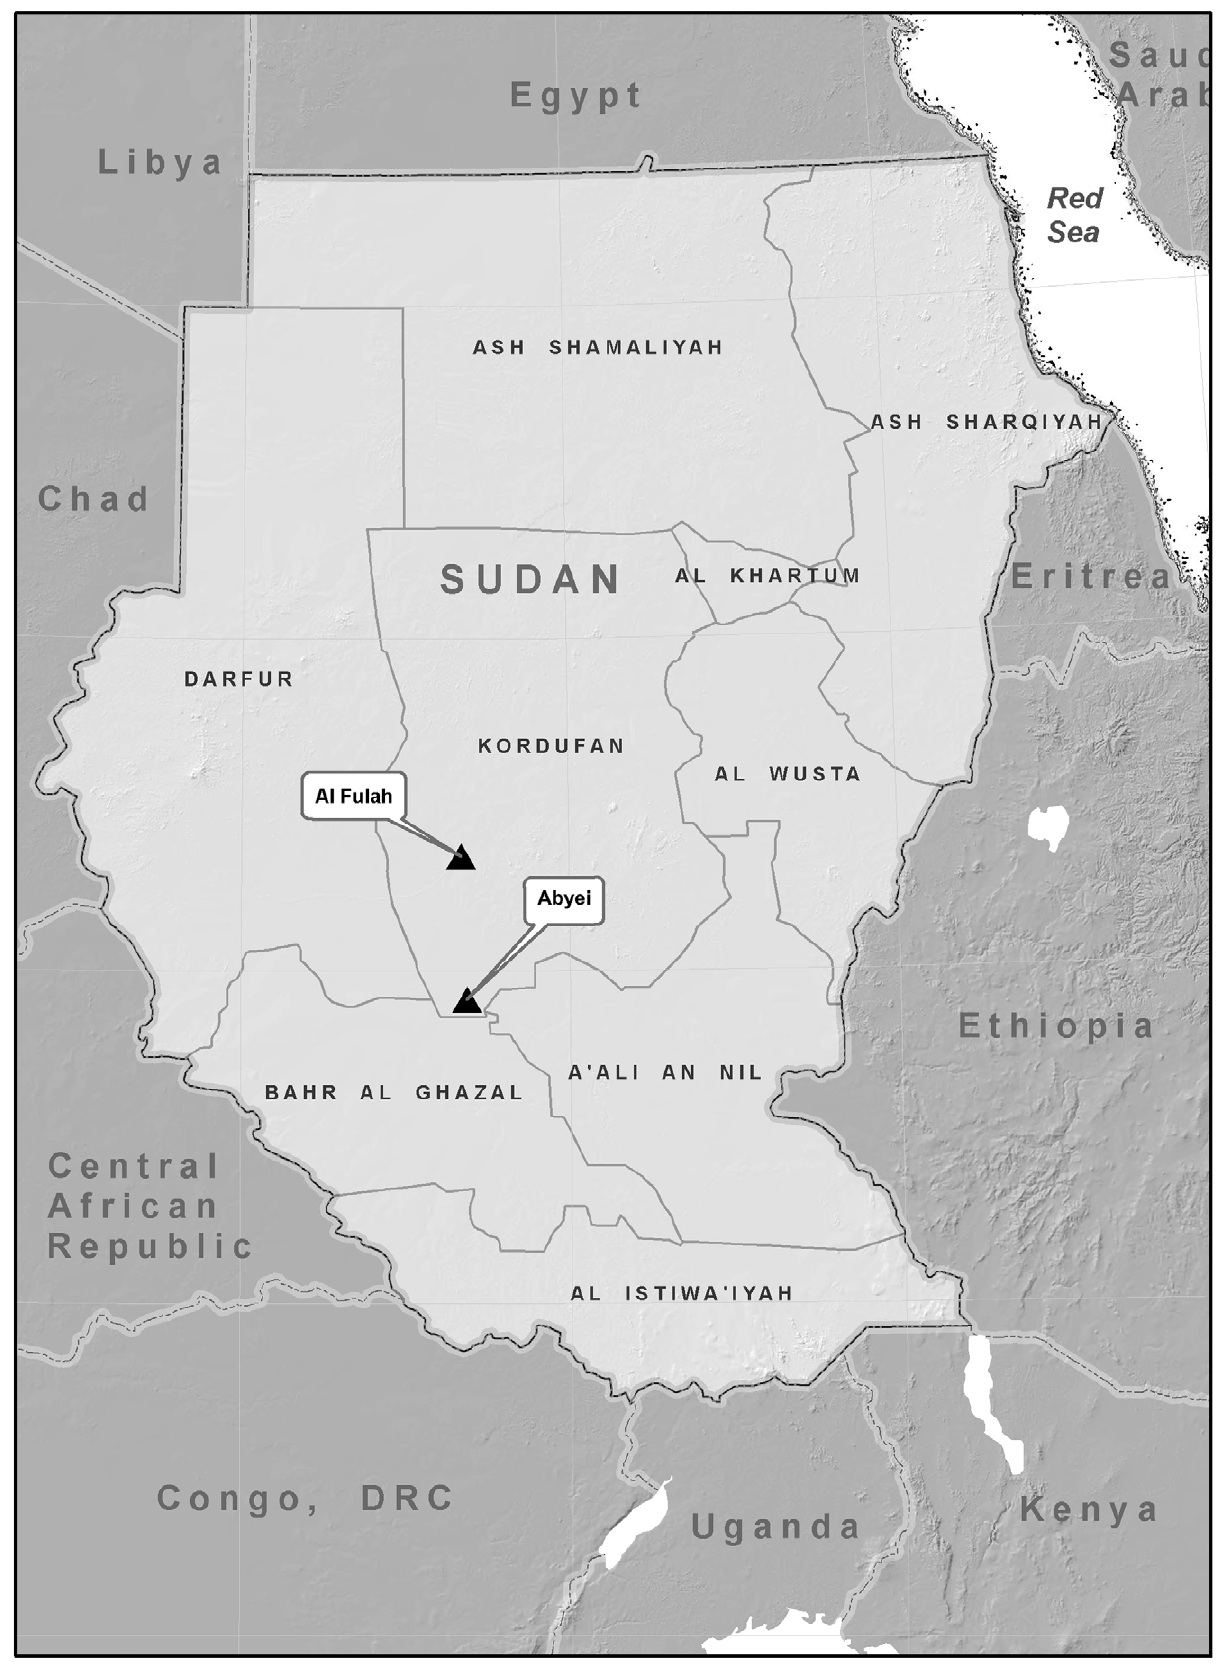
Figure 1. Map of Sudan showing the location of Abyei and Al-fulah towns in Kordufan region, Sudan.